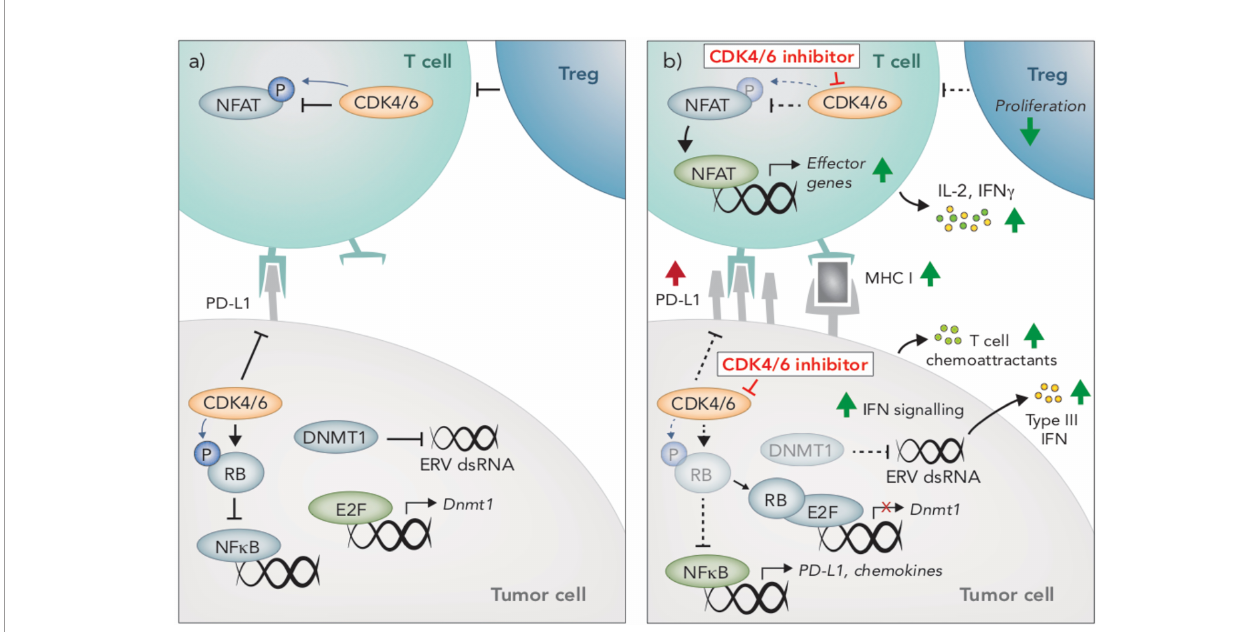
FIGURE 3 | Immunomodulatory effects of CDK4/6 inhibition. (A) CDK4/6 inhibition modulates anti-tumor immunity through multiple mechanisms. In tumors cells, CDK4/6 inhibition leads to hypophosphorylated RB, which binds to and inhibits the activity of E2F transcription factors. Reduced E2F activity leads to an induction of Type III interferons (IFN), resulting in paracrine IFN signaling and upregulation of MHC I. This induction of IFN is due to the suppression DNMT1, (an E2F target gene), which reduces methylation of endogenous retroviral (ERV) genes, thereby promoting their expression and inducing viral mimicry. Hypophosphorylated RB also promotes activation of NF k B and subsequent upregulation of T cell chemoattractants and PD-L1. (B) CDK4/6 inhibition also prevents PD-L1 degradation, further enhancing PD-L1 protein expression on the cells surface. In T cells, NFAT activity is restrained by CDK4/6-mediated phosphorylation. Following CDK4/6 inhibition, hypophosphorylated NFAT translocates to the nucleus and upregulates expression of effector genes. Compared to other lymphocyte populations, T regulatory cells appear particularly susceptible to the anti-proliferative effects of CDK4/6